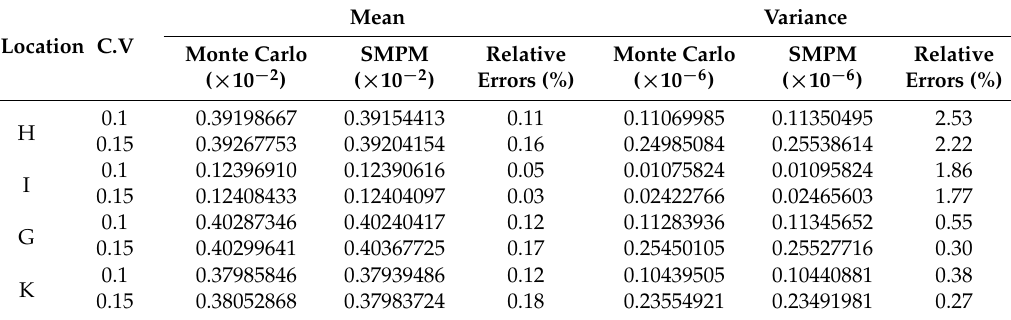
Table 8. The mean and variance of the deviatoric stress S 22